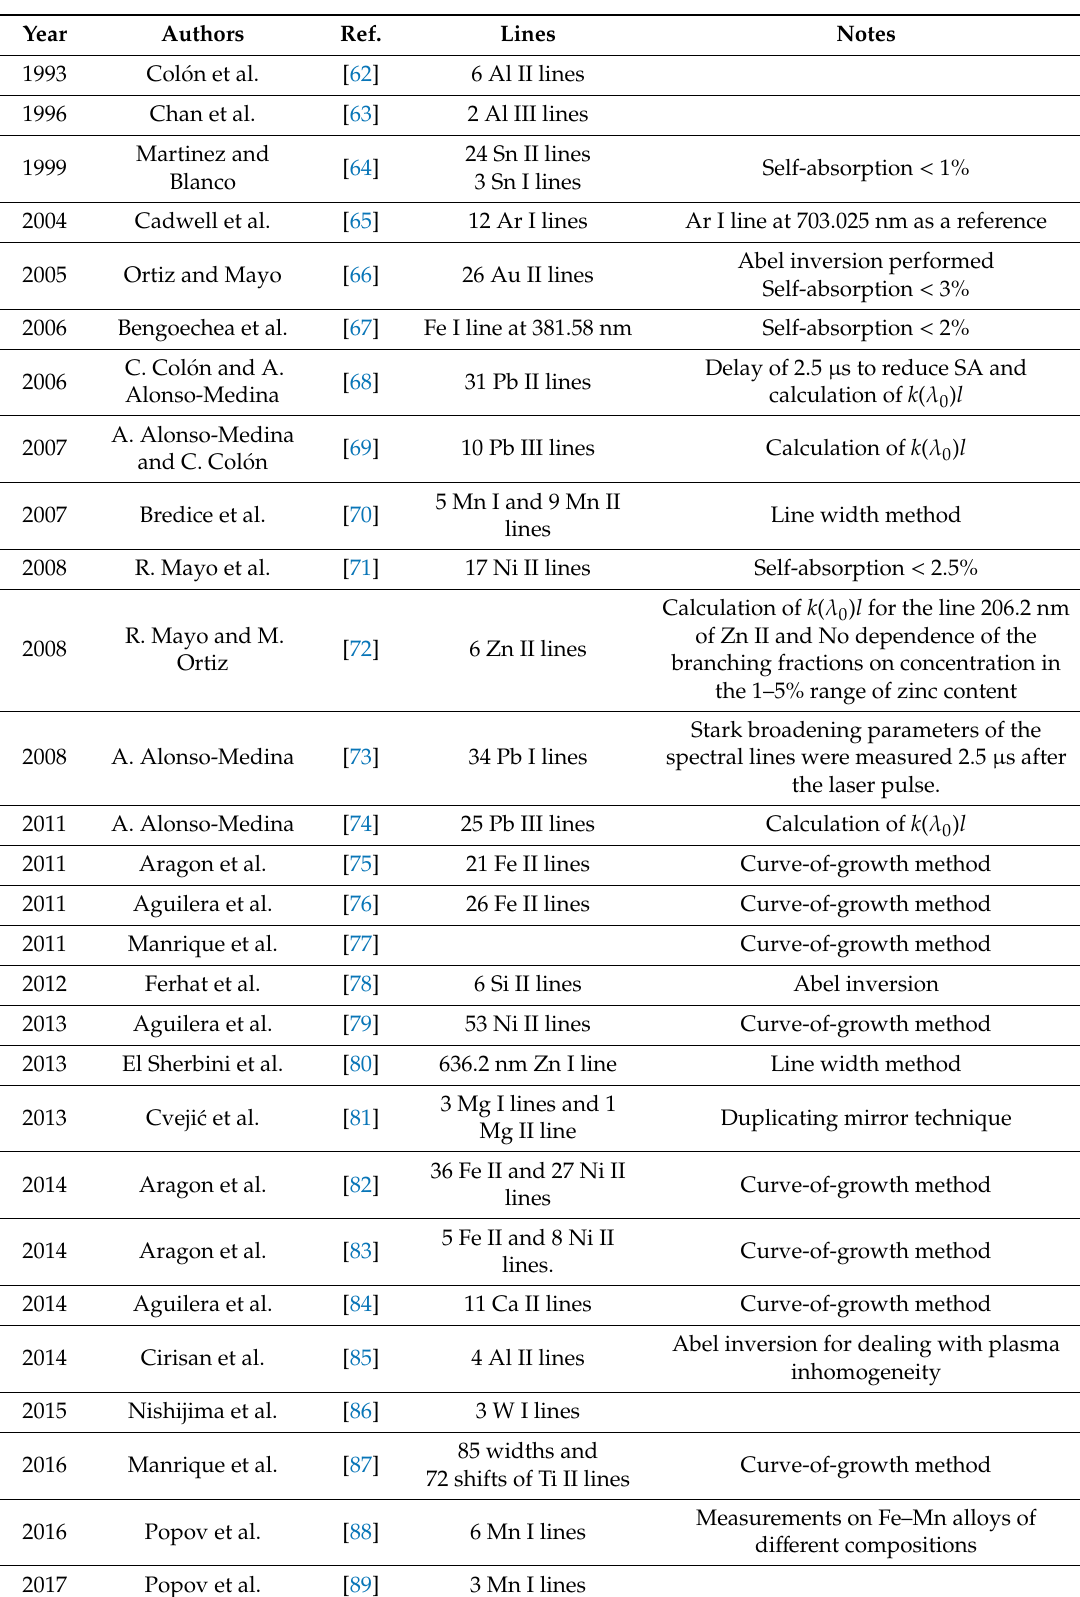
Table 1. Applications of LIBS for determining the Stark broadening coe ffi cients of atomic